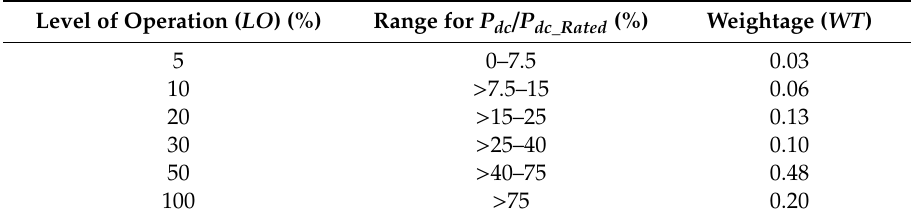
Table 1. The ranges for P dc / P dc_rated and weightage for each level of operation for η EURO . Level of Operation ( LO ) (%) Range for P dc / P dc_Rated